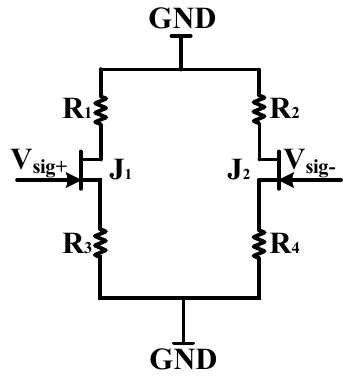
Figure 7. AC equivalent path of JFET differential circuit.